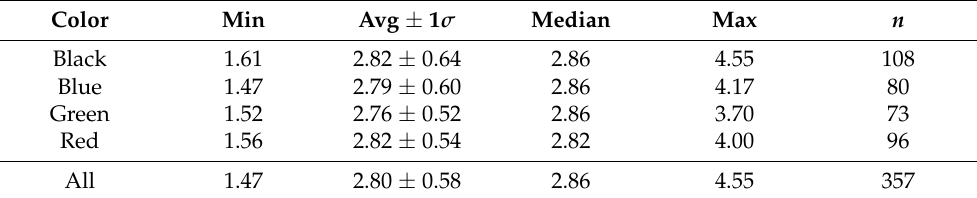
Table 5. Experiment #2. Crawl speeds of Coccotrypes dactyliperda (in mm/s) towards colored sectors.